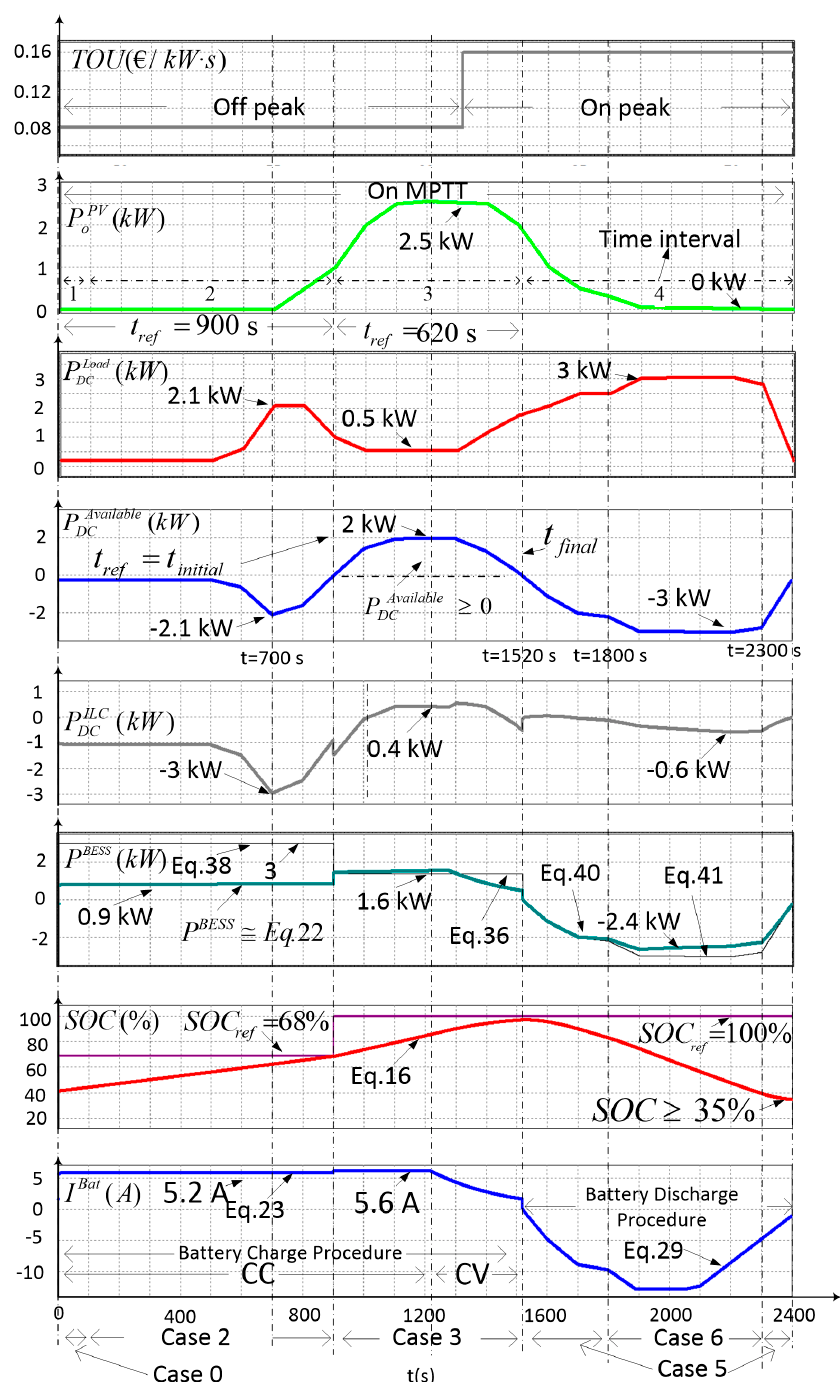
Figure 13. Simulation #2: Simulation results of the power management in the MG. 100 s corresponds to 1 h. 1520 s < time < 1800 s: The MGCC applies case 5. In this case, the MGCC sends to the BESS the power reference, P BESS = Equation (40) and the target SOC, SOC ref = 35%, at t ref = 880 s. The MGCC orders to import the minimum possible power from the